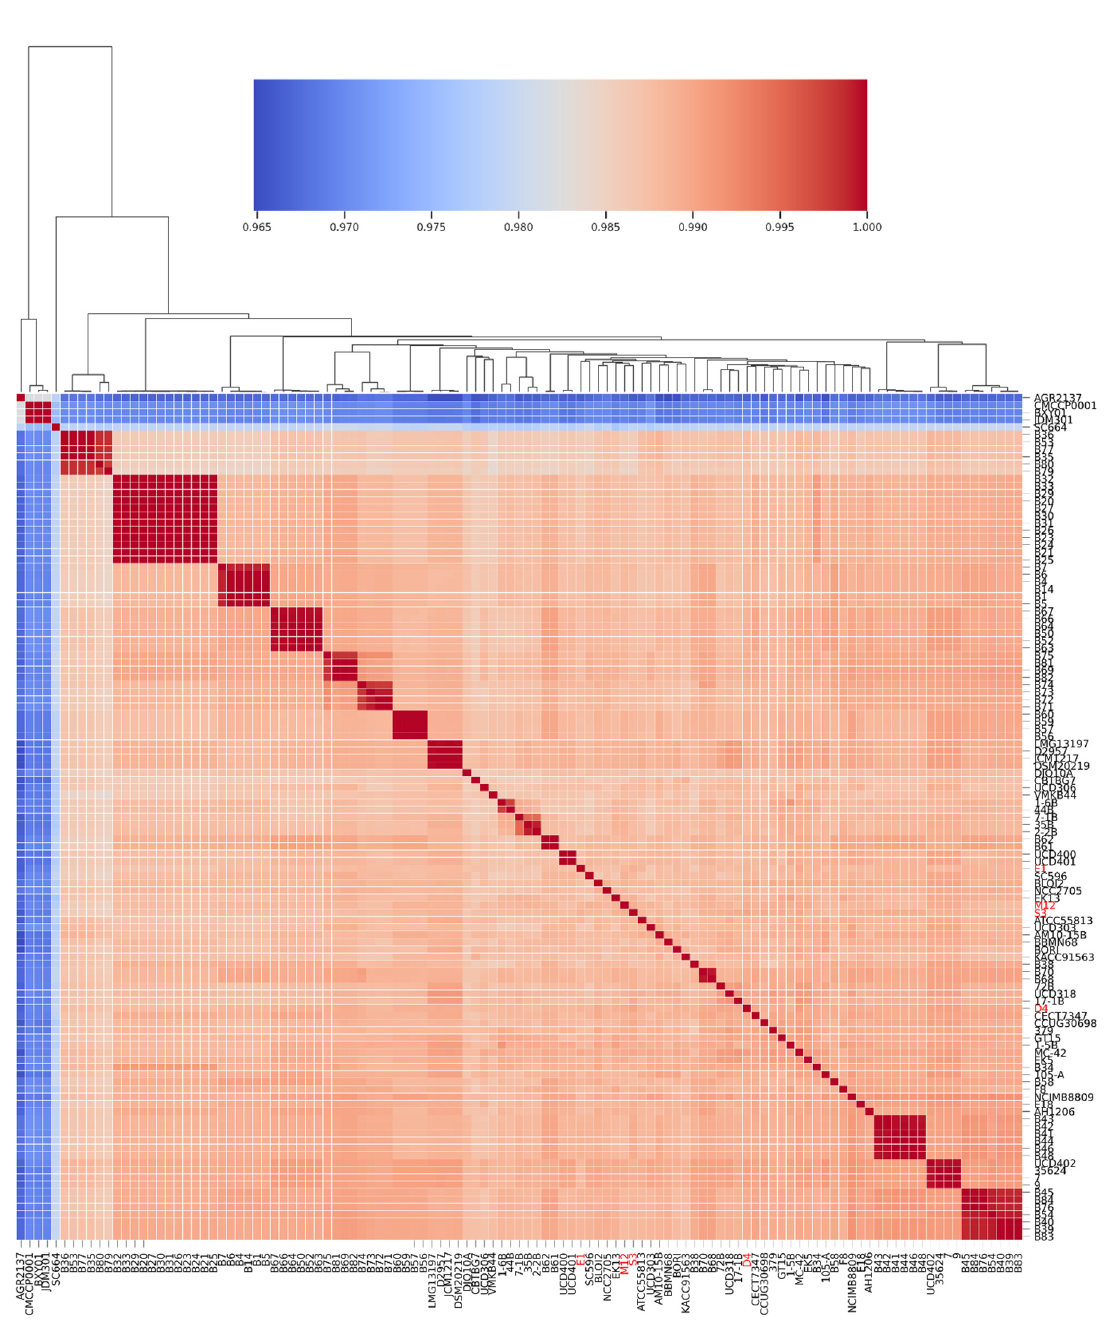
Figure 2. Heatmap representing the percentage of average nucleotide identity (ANI) of 158 B. longum subsp. longum strains. The color key represents the percentage identity among strains with lower (blue) and higher (red) ANI values. The strains are clustered in dendrograms based on row means. The Chilean strains are colored in red.